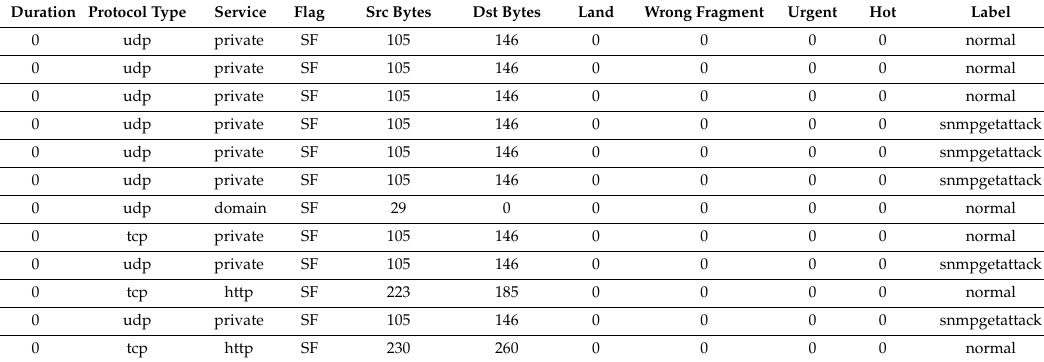
Table 5. KDDCup data log.